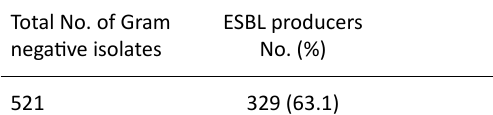
Table 3. Antibiotic susceptibility pattern of ESBL producers